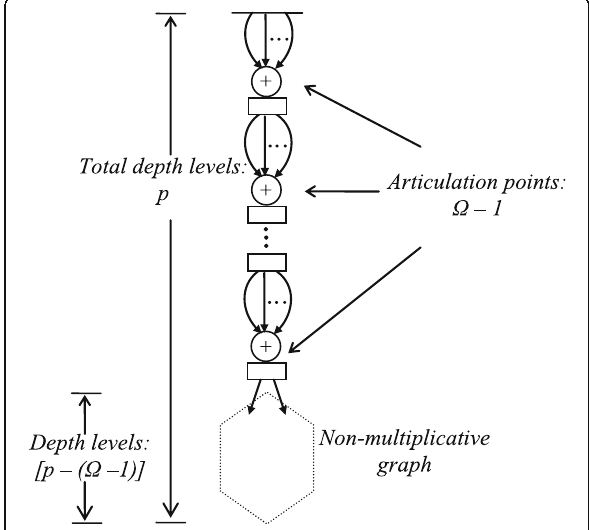
Fig. 10 Generalized graph that generates the maximum number of non-zero digits, n p , with the minimum number of R -operations in a multiplicative graph for constants with less prime factors than the minimum number of depth